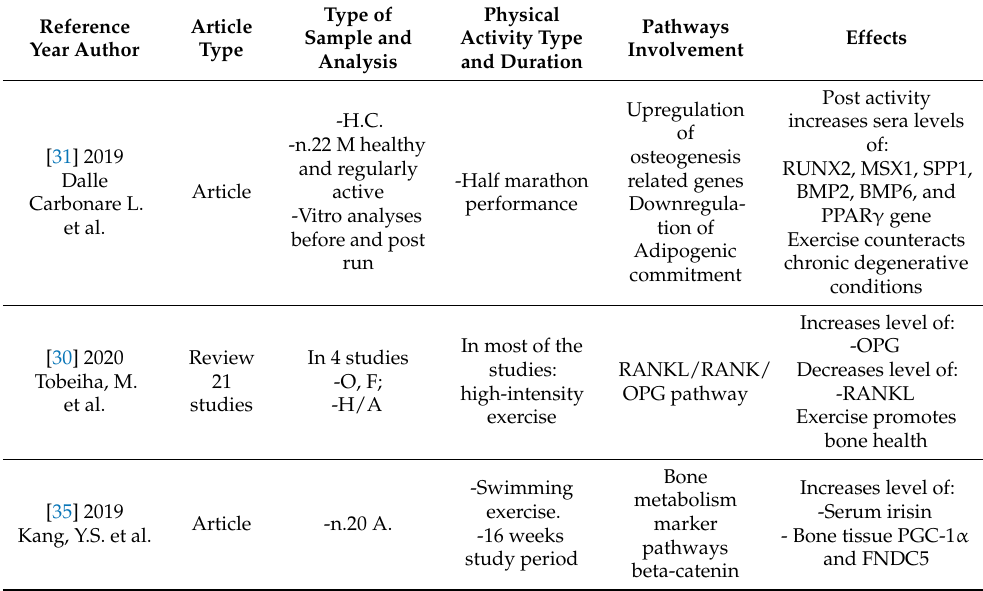
Table 1. Physical activity and modulation